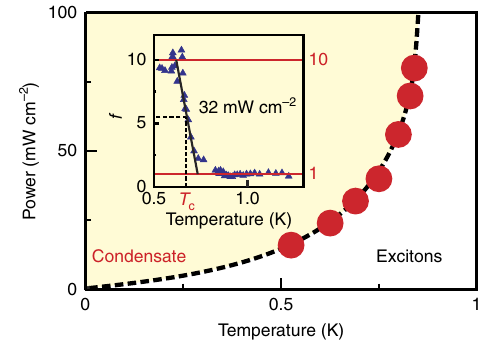
Figure 2 | Phase diagram of CME condensation. Phase boundary separating incoherent gas and condensate of spin-triplet CMEs (dots). The saturation of the phase boundary at large photoexcitations is due to a limited amount of CMEs that the electron system can accumulate (around 0.15 of Landau spin sublevel degeneracy number N F ). The dashed line serves solely as an eye cursor. The inset illustrates how the critical temperature is chosen (half the height of the threshold increase of oscillator strength f ( T